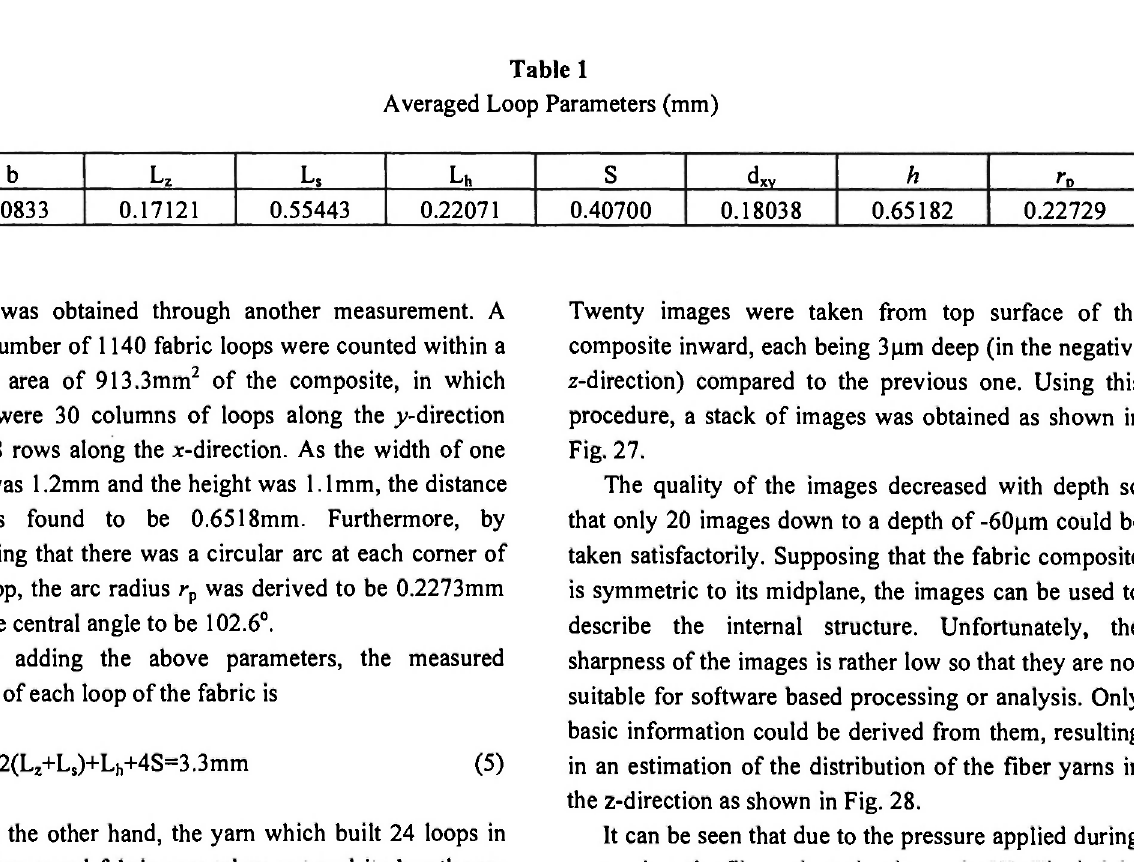
Averaged Loop Parameters (mm)